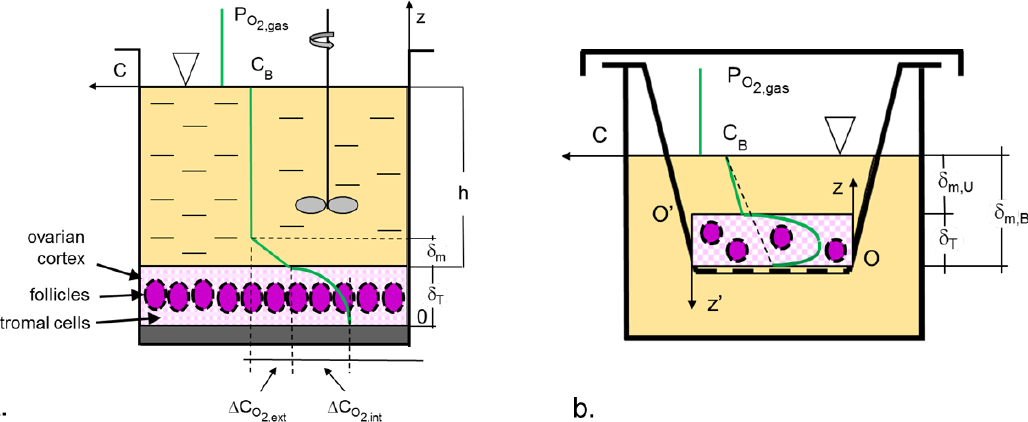
Figure 2. Bioreactor schemes used for the transport models and qualitative dissolved oxygen concentration profile in the medium and inside the fragment: ( a ) conventional or mixed dish in which oxygen is supplied only through the upper fragment surface, and ( b ) submerged fragment culture on a permeable membrane at the bottom of an insert suspended in a well of a 24-well plate. Captions: C—dissolved oxygen concentration; C B —dissolved oxygen concentration in the medium at equilibrium with pO 2,gas ; pO 2,gas —gaseous oxygen tension above the medium surface; δ m and δ m,U or δ m,B —thickness of the medium layer above or below the strip, respectively; T —thickness of the tissue fragment; ∆ CO 2,ext —external dissolved oxygen concentration drop in the medium; ∆ CO 2,int —internal dissolved oxygen concentration drop in the fragment. Other symbols are defined in the text. Please note that drawings are not to